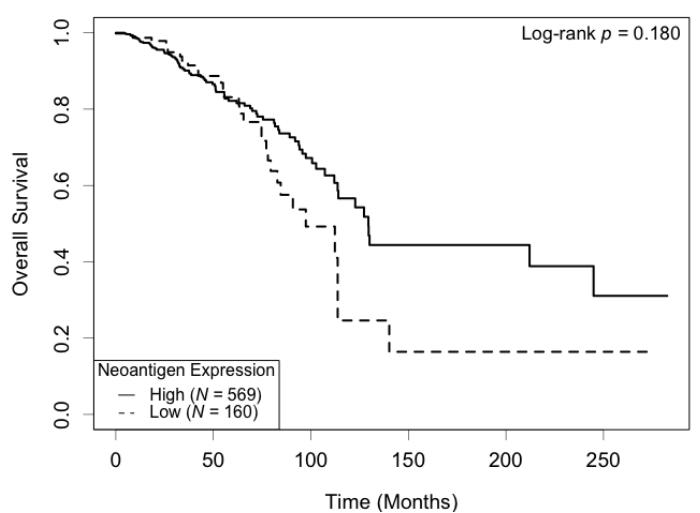
Figure 2. Kaplan–Meier survival curve of neoantigen expression. There was no significant difference in overall survival between patients in high and low levels of neoantigen expression ( p = 0.180).